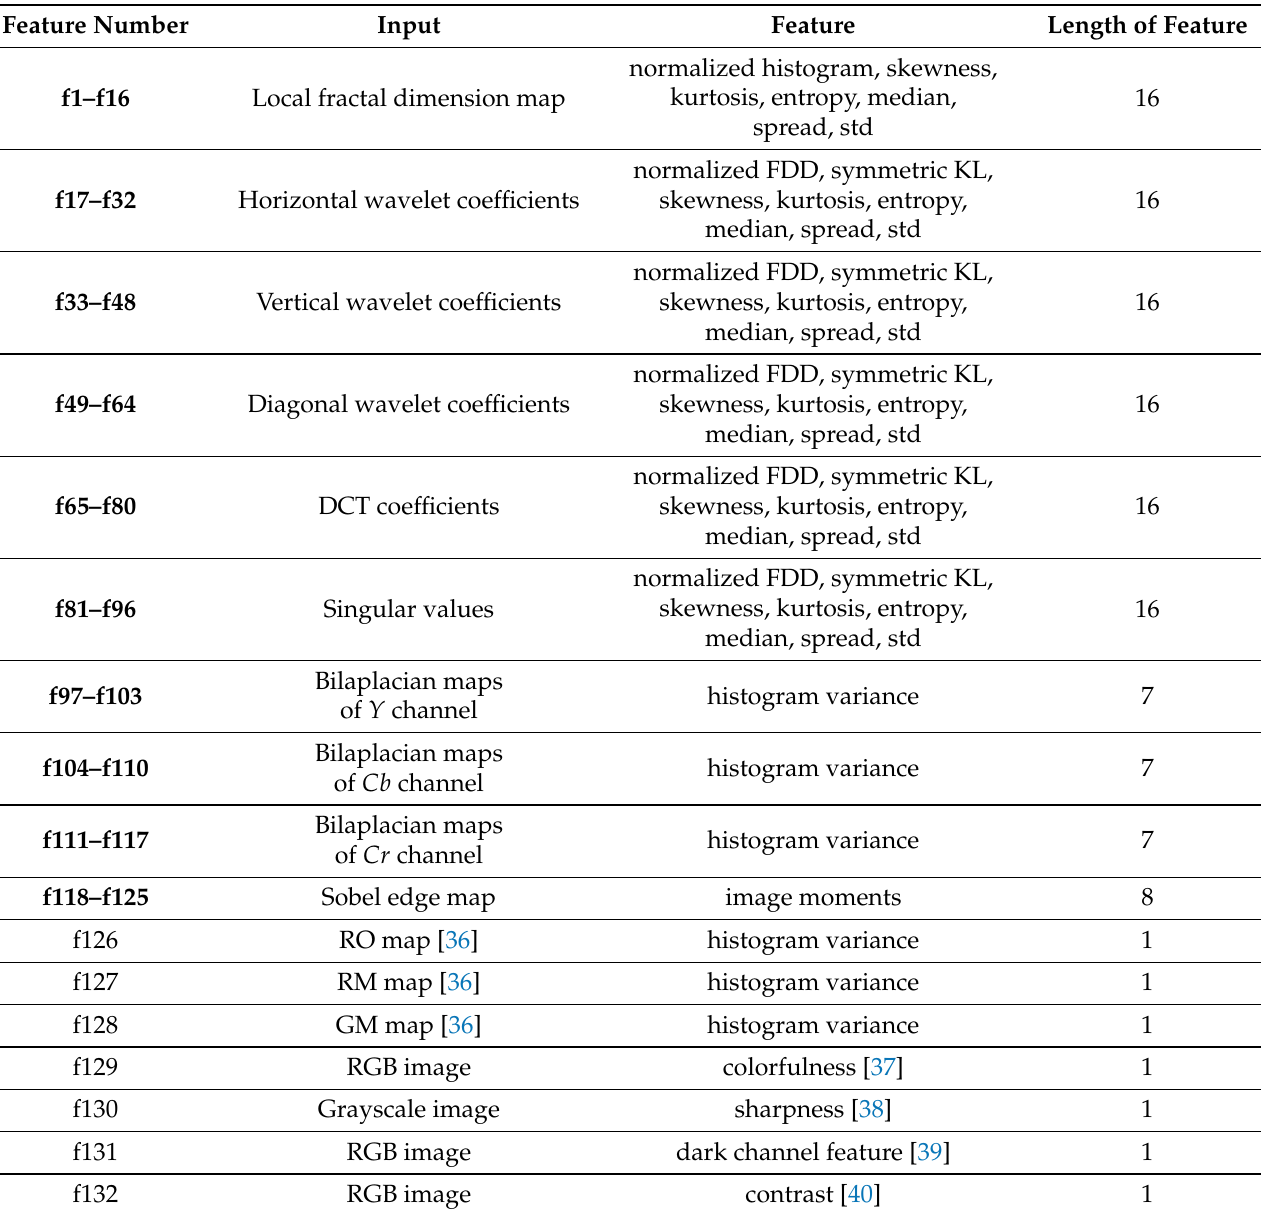
Table 1. Summary of features applied in the introduced no-reference image quality assessment (NR-IQA) algorithm. Quality-aware features proposed in this study are typed in